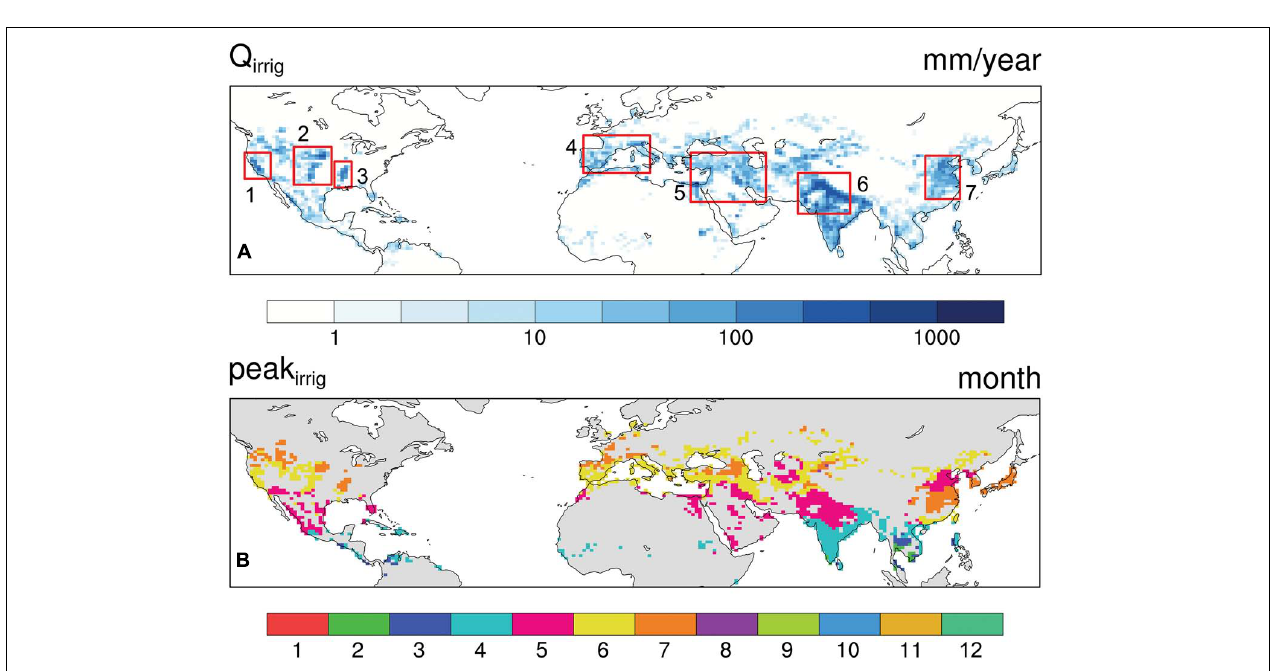
FIGURE 2 | Total amount of irrigated water (Q irrig in mm/year) on a log scale (A) and the month with the highest irrigation rate (B) . The red boxes show the seven subregions: 1. California’s Central Valley (CA), 2. the Great Plains (GP), 3. the Mississippi Embayment (MS), 4. Southern Europe (SE), 5. the Middle East (ME), 6. India (IN), and 7. Eastern China